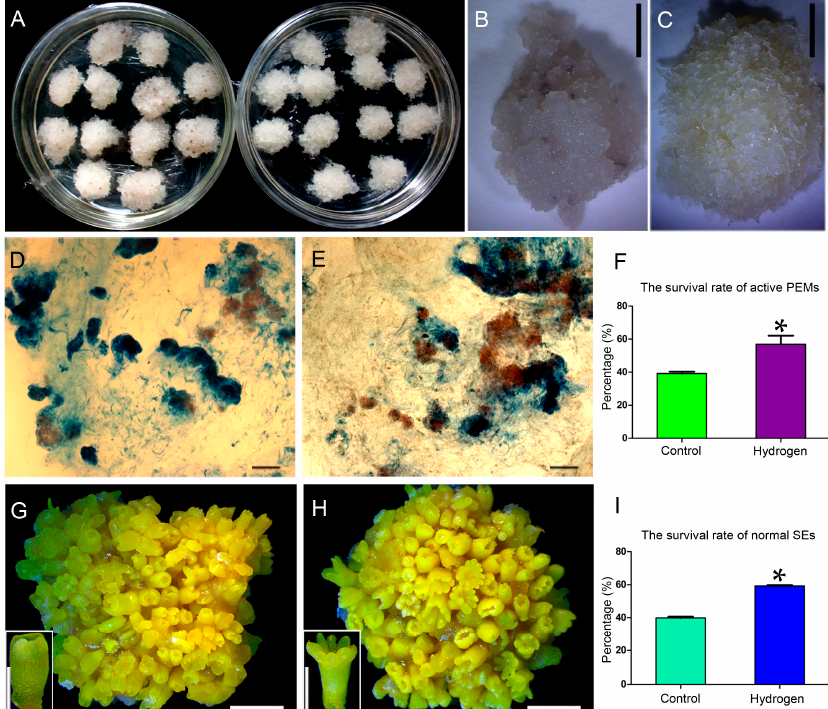
Figure 1. Effect of exogenous hydrogen treatment on pro-embryogenic masses (PEMs) and somatic embryos (SEs) during somatic embryogenesis. ( A ) PEMs sub-cultured on control medium ( left ) and hydrogen-rich medium ( right ). Magnified PEMs on control medium ( B ) and hydrogen-rich medium ( C ). Double-stained PEMs sub-cultured on control medium ( D ) and hydrogen-rich medium ( E ). Active pro-embryogenic cells stained red (acetic acid-carmine); inactive pro-embryogenic cells were stained blue (Evans blue). ( F ) Frequency of active PEMs on the different media. SEs sub-cultured on control medium ( G ), with insert showing an abnormal SE, and hydrogen-rich medium ( H ), with insert showing a normal SE. ( I ) Incidence of normal SEs sub-cultured on the different media. Data are presented as mean ± standard error from three independent experiments. Asterisks indicate significant difference at * p < 0.05 by Student’s t test. Scale bars, 5 mm in ( B , C , G , H ); 500 µm for insets ( G , H ); and 200 µm in ( D , E ).